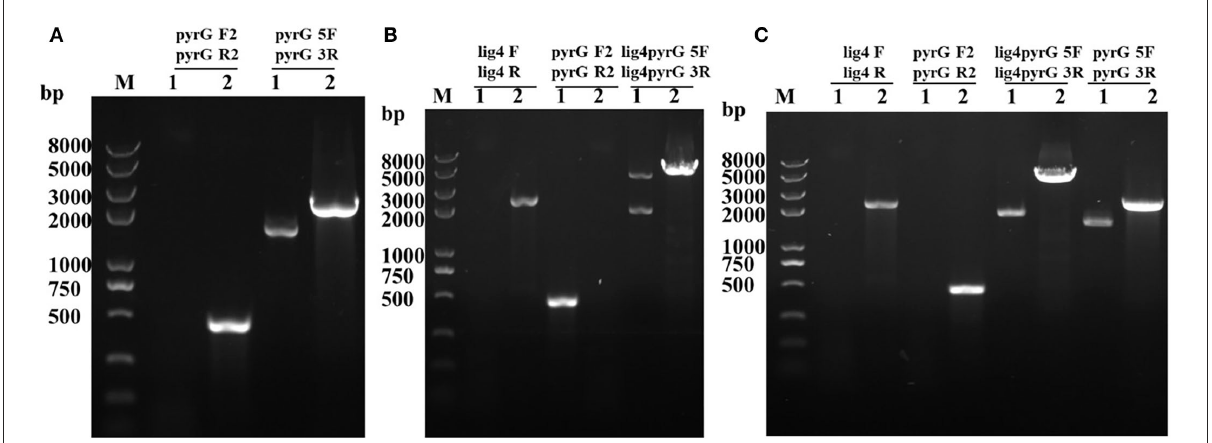
FIGURE2 PCR analysis of 1 mrpyrG , 1 pyrG + lig4 :: pyrG , and 1 pyrG + lig4 . (A) Confirmation of mrpyrG deletion. Lane 1: 1 mrpyrG ; Lane 2: M7; M: Trans 2K plus II marker; (B) Confirmation of mrlig4 markerless deletion in 1 mrpyrG strain. Lane 1: 1 pyrG + lig4::pyrG ; Lane 2: 1 mrpyrG ; (C) Confirmation of mrpyrG homologous recombination events in 1 pyrG + lig4 :: pyrG strain. Lane 1: 1 pyrG + lig4 ; Lane 2: M7; M: Trans 2K plus II